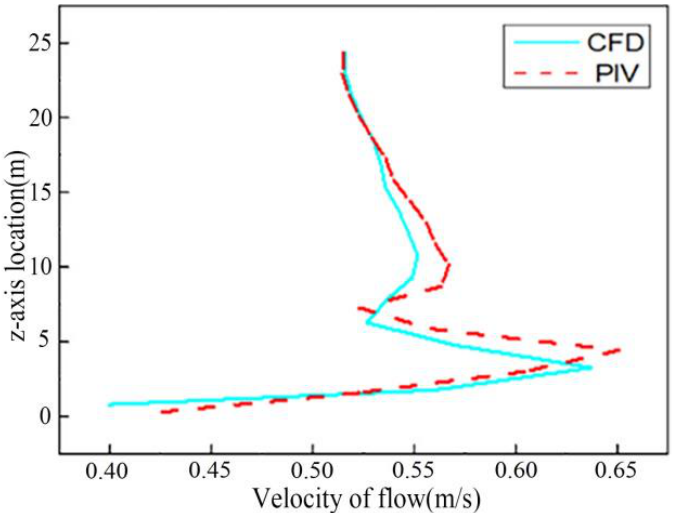
Figure 2. The streamline diagram of PIV ( a ) and CFD ( b ).